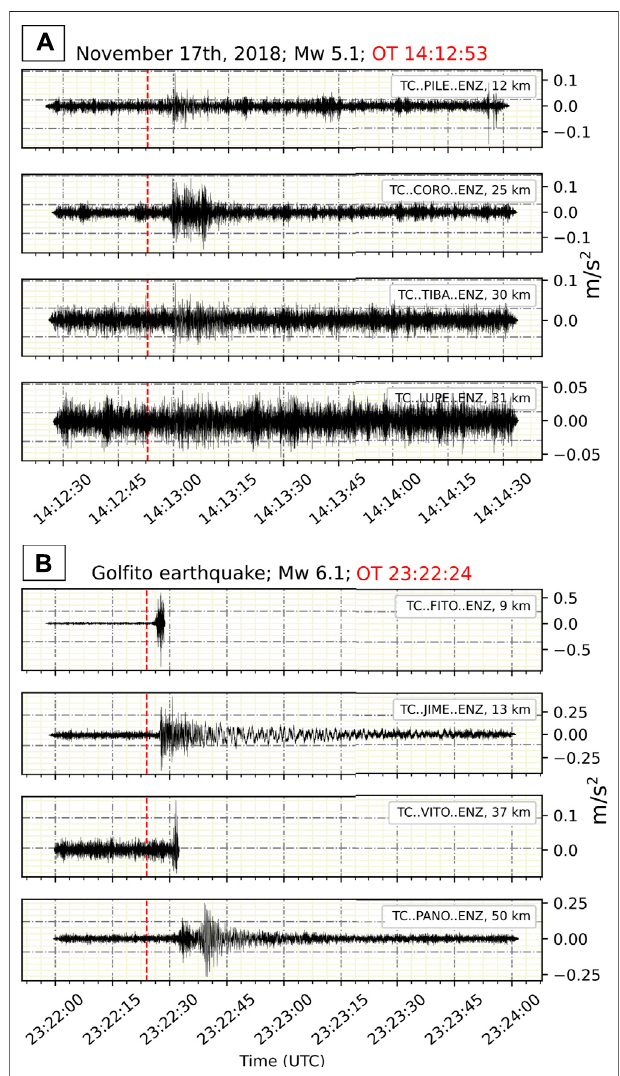
FIGURE 8 | Closest four vertical SM recordings of the (A) November 17th, 2018 (Mw 5.1), and (B) Gol fi to (Mw 6.1) earthquakes. The vertical red lines indicate the origin times. Left vertical axis is in counts and the corresponding acceleration value is indicated in the right vertical axis. The epicentral distance of each station is indicated in the labels after the station name. (A) The low resolution of the strong motion MEMS sensors and (B) the lost signals shortly after the P-wave arrival during the Gol fi to earthquake, most likely due to failure of communication or mains power.